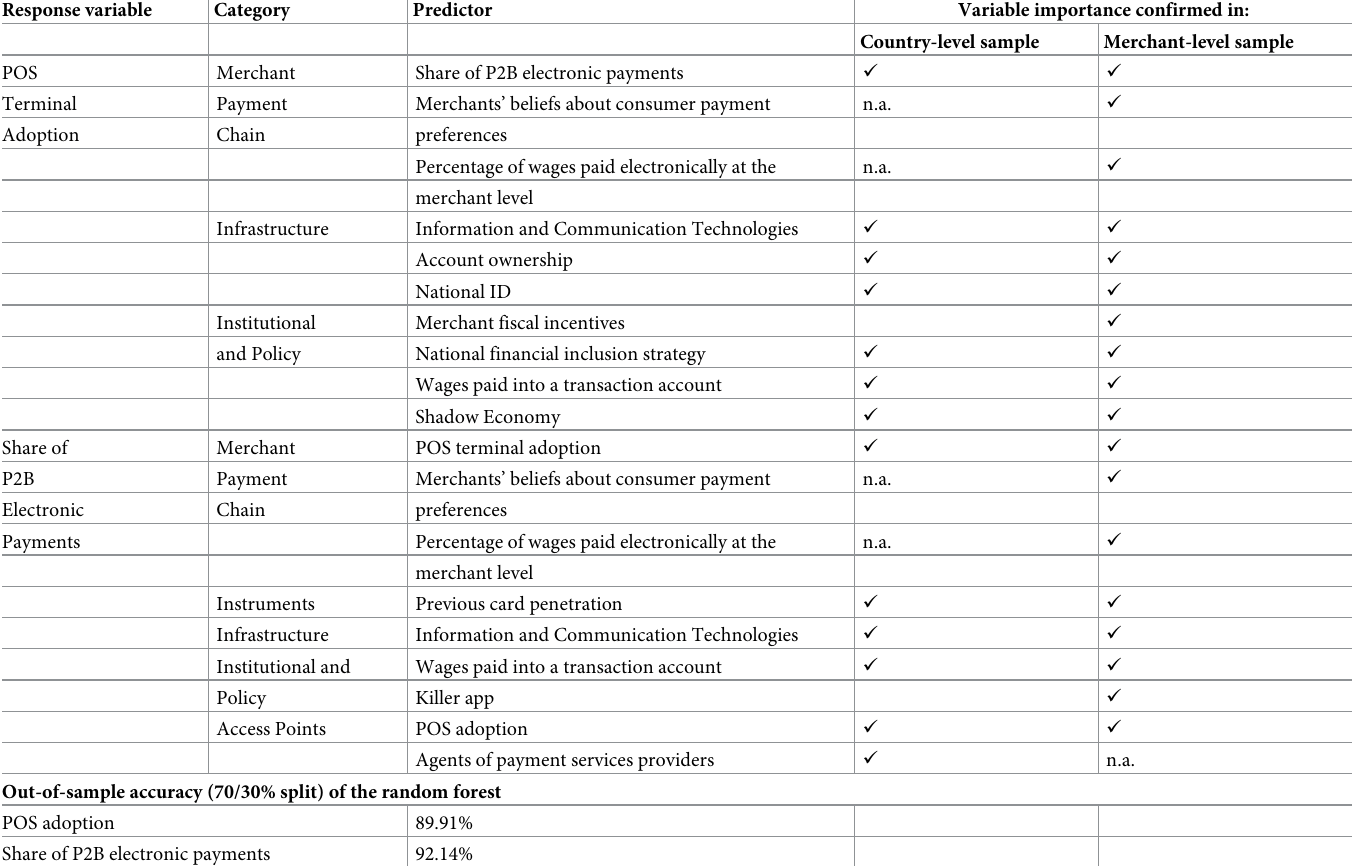
Table 1. Main predictors of POS adoption and share of P2B electronic payments (combined results from the country-level and merchant-level samples). Response variable